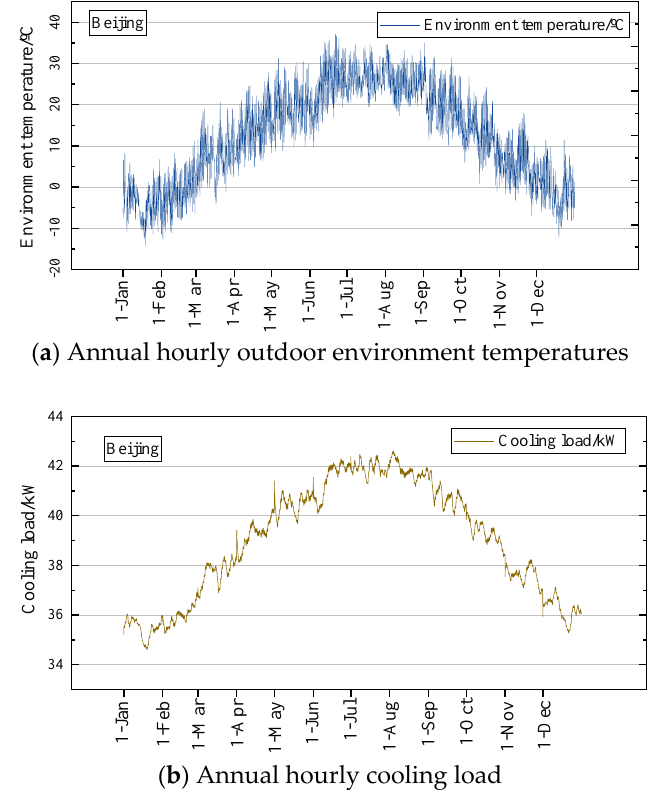
Figure 24. Annual hourly ( a ) outdoor environment temperatures and ( b ) cooling load of Beijing.